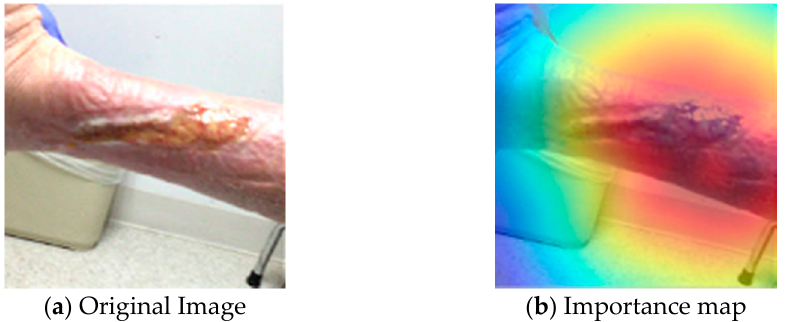
Figure 10. The probabilities of wound types: Lymphovascular: 87.8%, diabetic: 7.4%, pressure injury: 4.8%, surgical: 7.3% (Lymphovascular).